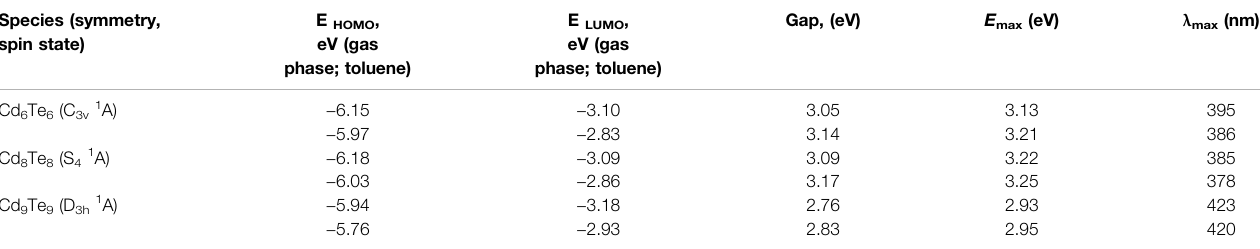
E LUMO , eV (gas phase; toluene)